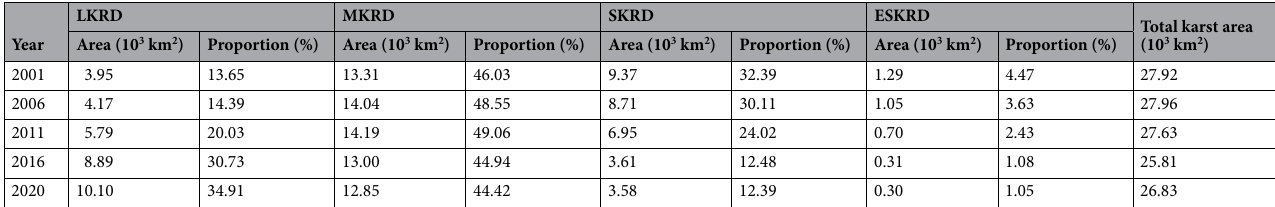
Table 3. Change in the karst rocky desertification areas of different